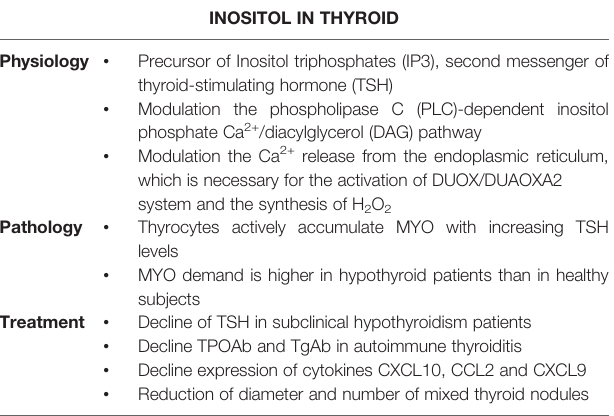
TABLE 1 | Effects of inositol on thyroid